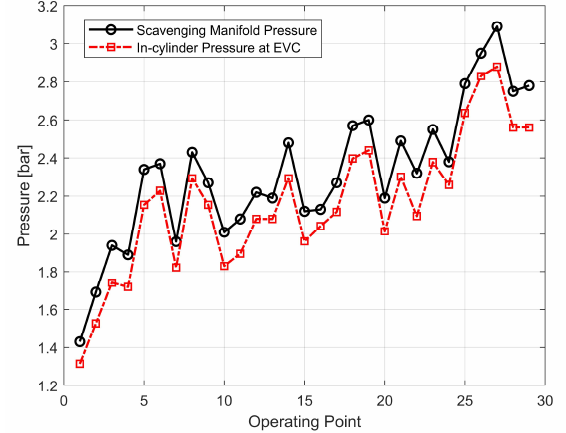
Figure 17. Comparison between scavenging manifold pressure and in-cylinder pressure at exhaust valve closing (EVC) based on measured data.